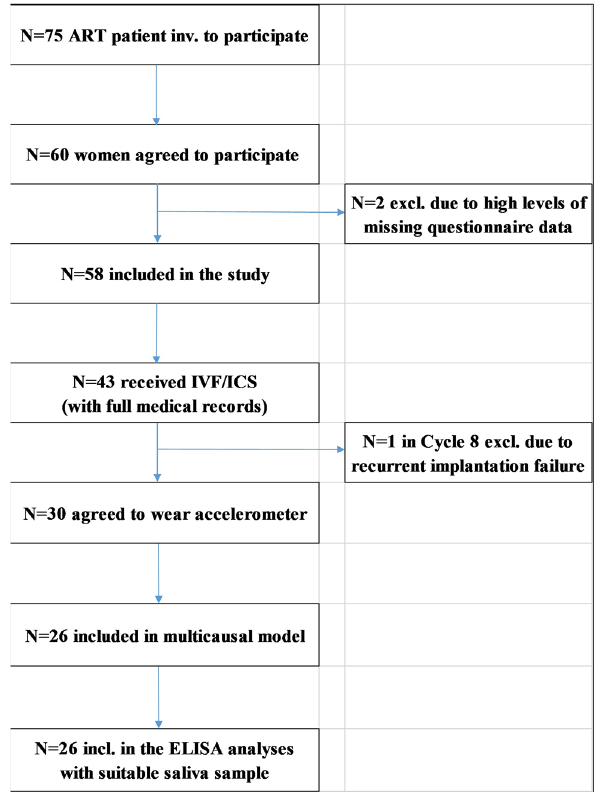
Figure 1. Flow diagram of patients’ enrolment.